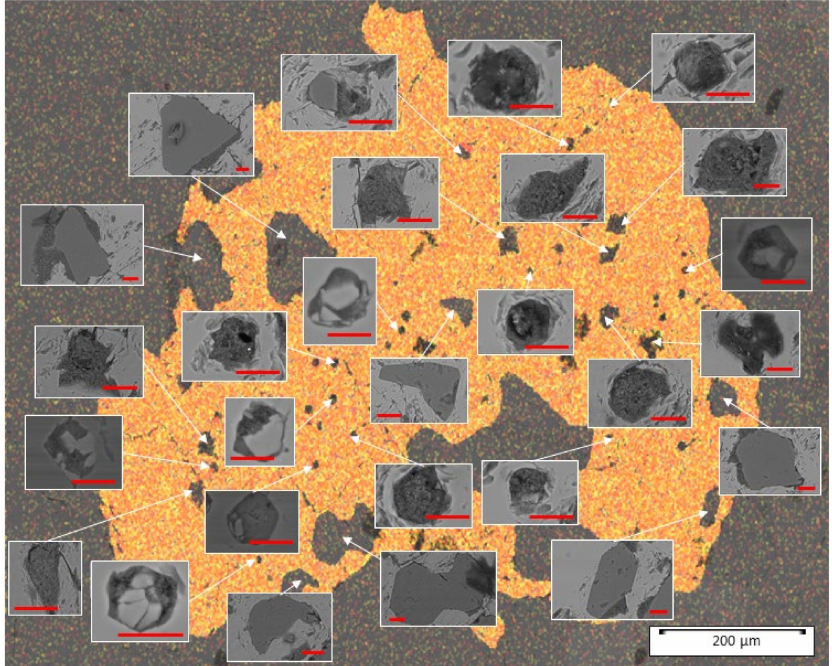
Figure 4. Collage of back-scattered electron images of MPIs superimposed on an Mn/Fe-distribution map of the host garnet, showing the typical abundance and distribution of MPIs in host minerals of this study. MPIs comprise both voids and various solid phases (quartz, micas, apatite, feldspar and unidentified phases with Al-Mg-Si ± Ca ± Fe chemistry). The size of MPIs varies from tens to hundreds of microns. Inset scale bar = 15 microns. Sample QC26C, gneiss,